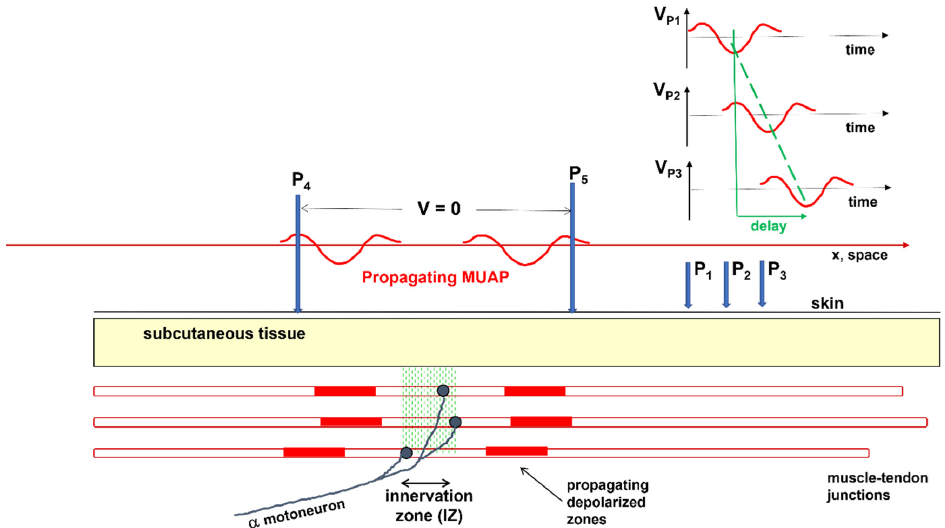
Figure 5. Schematic drawing of the right and left propagation of a motor unit action potential (MUAP) in time and space and the estimation of muscle fiber conduction velocity. When the distance between P1 and P3 is 20 mm and the delay is 5 ms, the muscle fiber conduction velocity is 20/5 = 4 mm/ms = 4 m/s. P1, P2, and P3 must be on the same side of the innervation zone. The signals detected by P1, P2, and P3 are called “monopolar”. The signals detected between P1–P2, P2–P3, and P1–P3 are called “bipolar” or “single differential (SD)”. The SD signal detected between P4 and P5 is near zero because of the symmetrical position of P4 and P5 with respect to the innervation zone. Modified from https://www.robertomerletti.it/en/emg/material/teaching/module5. (See animation in Supplementary Materials, Sup3).